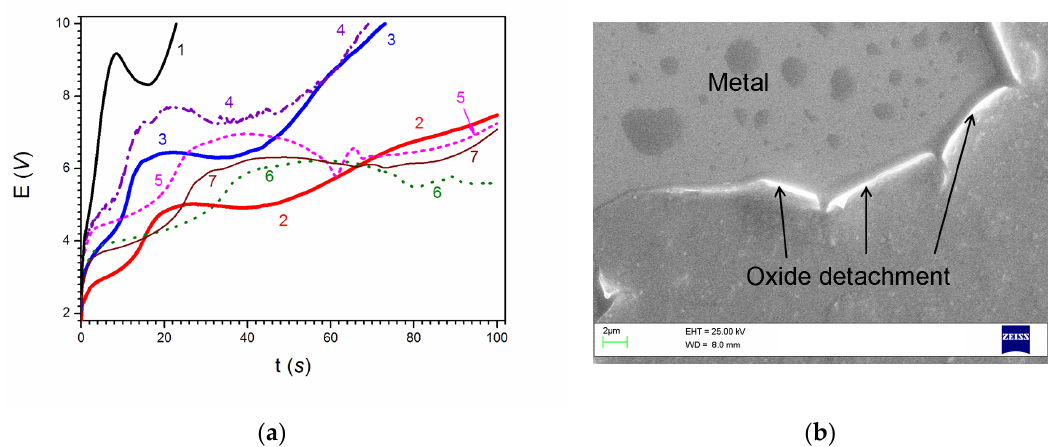
Figure 1. Galvanostatic anodic oxidation of the Fe70Cr15B15 amorphous alloy in 1-butyl-3-methylimidazolium tetrafluoroborate: ( a ) Potential ( E ) as a function of time ( t ) for: 1-untreated sample, 2-mechanically abraded, 3 and 4-preliminarily etched with 1.6 and 0.013 M acetone solutions of citric acid, respectively, 5-preliminarily treated with an acetone benzoic buffer solution (0.013 M benzoic acid + 0.013 M sodium benzoate), 6-preliminarily treated with a NaOH acetone solution, 7-preliminarily treated with an NaOH aqueous solution; ( b ) SEM images of the Fe70Cr15B15 amorphous alloy surface of the abraded sample illustrating the detachment of the anodic oxide film after anodic oxidation in IL and oxide-free metal surface (the loose piece of